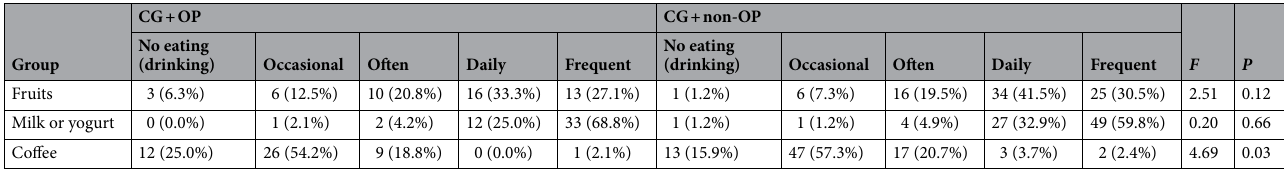
Table 3. Comparison of diet types between groups.